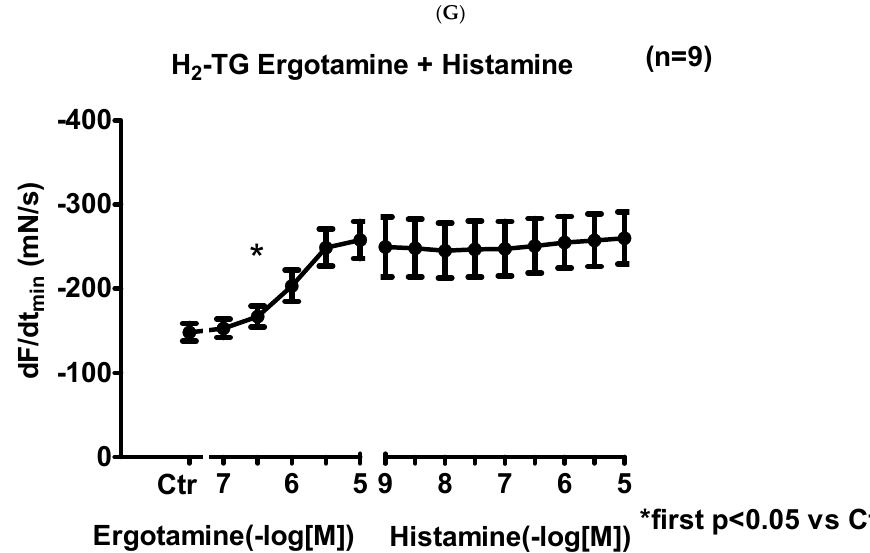
Figure 2. Ergotamine increases force in H 2 -TG. ( A ) Original recording in mouse left atrial preparations from H 2 -TG. It becomes apparent that ergotamine induced a time- and concentration-dependent positive inotropic effect. Black triangles indicate addition of ergotamine. Gray triangles indicate addition of histamine. ( B ) Original recordings in mouse left atrial preparations from WT. It becomes apparent that ergotamine did not induce a time- and concentration-dependent positive inotropic effect. ( C ) Summarized concentration–response curves for the effect of ergotamine or histamine on force of contraction. ( D : T1) Time to peak tension. ( E : T2) Time to relaxation. ( F : dF/dt max ) Rate-of- tension development. ( G : dF/dt min ) Rate-of-tension relaxation in H 2 -TG left atrial preparations. Ordinates in ( A – C ): force of contraction in milli-Newton (mN). Ordinate in ( D ) time to peak tension in milli seconds (ms). Ordinate in ( E ) time of relaxation in milli seconds (ms). Ordinate in ( F ) rate of contraction in mN/s and ordinate in ( G ) rate of relaxation in mN/s. Horizontal bars in ( A , B ) indicate time in minutes (min). Abscissae in ( D – F ) indicate concentrations of ergotamine or histamine in negative decadic logarithm of molar concentrations. * p < 0.05 vs. Ctr, first significant difference versus control (pre-drug value, Ctr). “n” indicates number of experiments given in brackets.